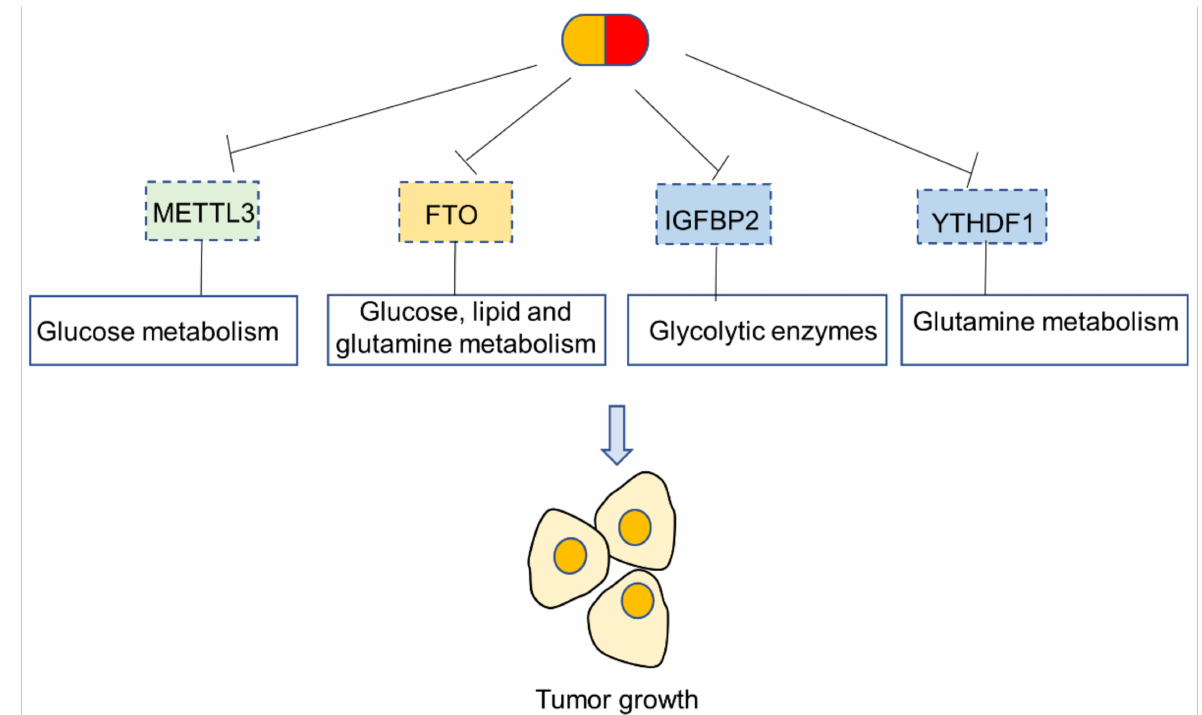
Figure 5. Therapeutic opportunities for targeting m 6 A regulators to reverse metabolic rewiring in